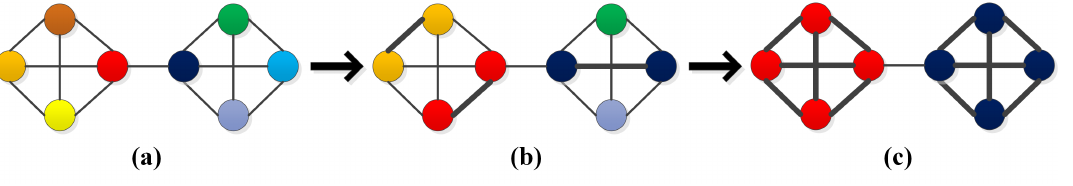
Figure 1. A sample on a simple network. ( a ) information initialization, ( b ) information dynamic interaction, ( c ) uncover